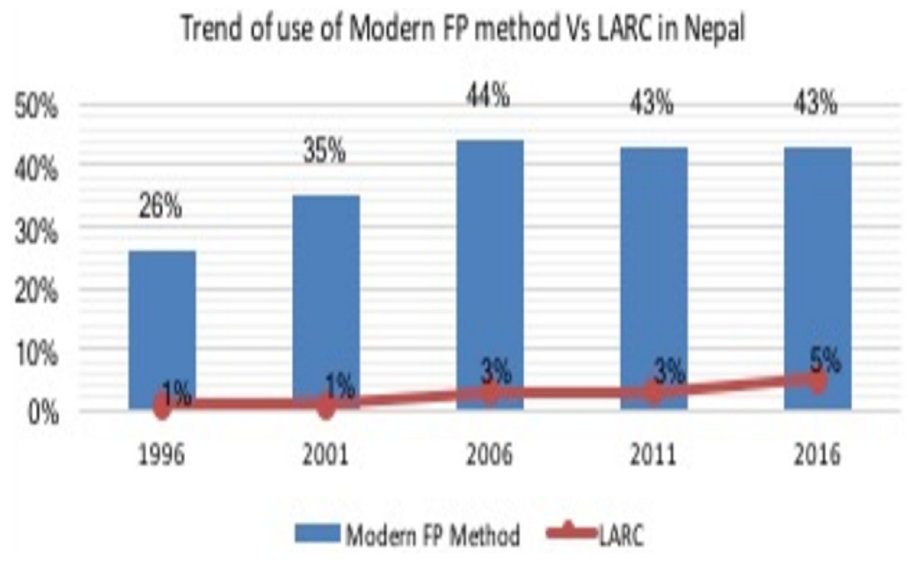
Fig 1. Trend of use of modern FP methods Vs LARC in